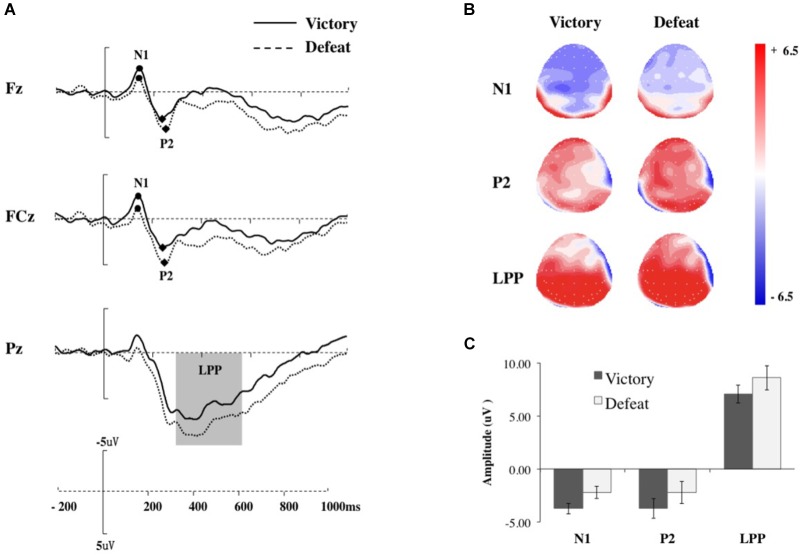
Results of experiments. (A) Representative example: ERP waveform in Fz, FCz, and Pz (from top to bottom); (B) topographic maps in Victory and Defeat conditions for N1, P2, and late positive potential (LPP); and (C) the mean amplitudes of N1 in F1/F2/Fz/FC1/FC2/FCz, and P2 in F1/F2/Fz/FC1/FC2/FCz, and LPP in P1/P2/Pz, and the error bars represent one SEM.